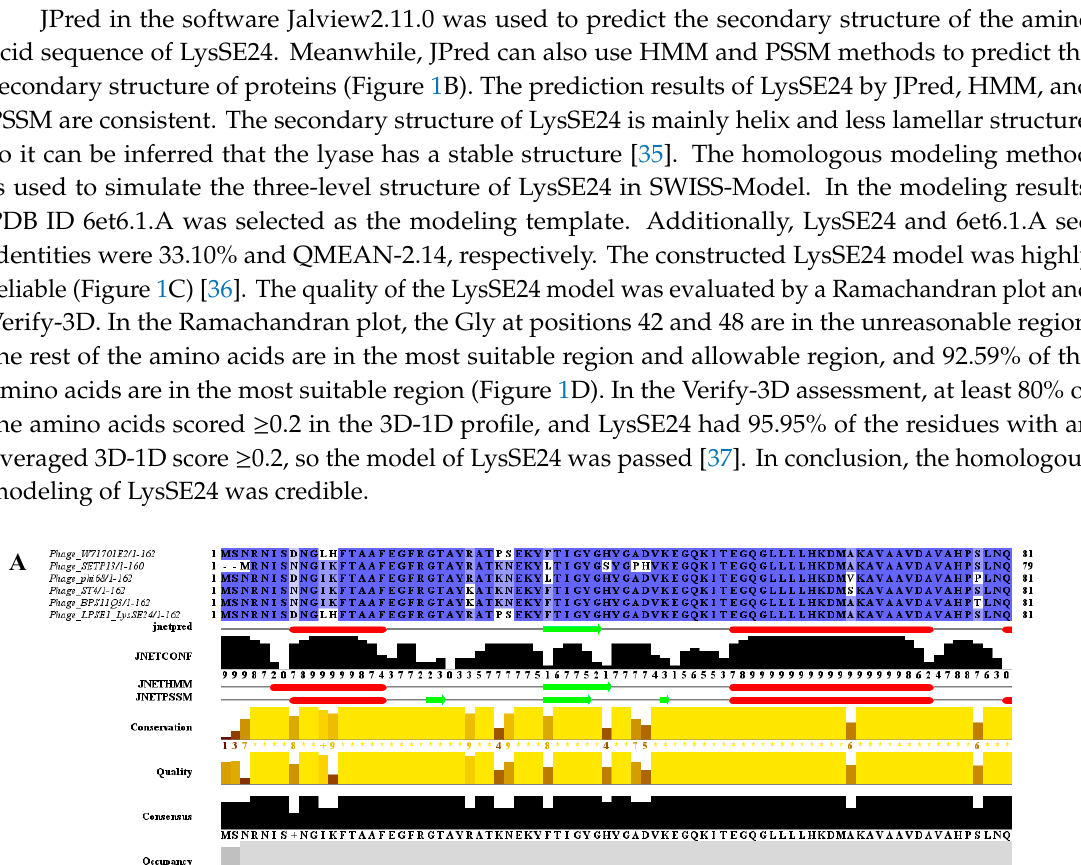
Figure 1. Bioinformatics analysis of LysSE24. ( A ) LysSE24 conserved domain analysis in NCBI Conserved Domain Database (NCMI CDD) and Pfam 32.0. LysSE24 carries out conservative domain search; it belongs to the Lyz endolysin autolysin domain family (Accession cd00737) between10 and 147 aa (E-value 1.27e-30), while Pfam predicted that LysSE24 had a phage lysozyme domain (Accession PF00959.19) from 33 to 141 aa (E-value 7.9e-14). ( B ) Multiple alignments of amino acid